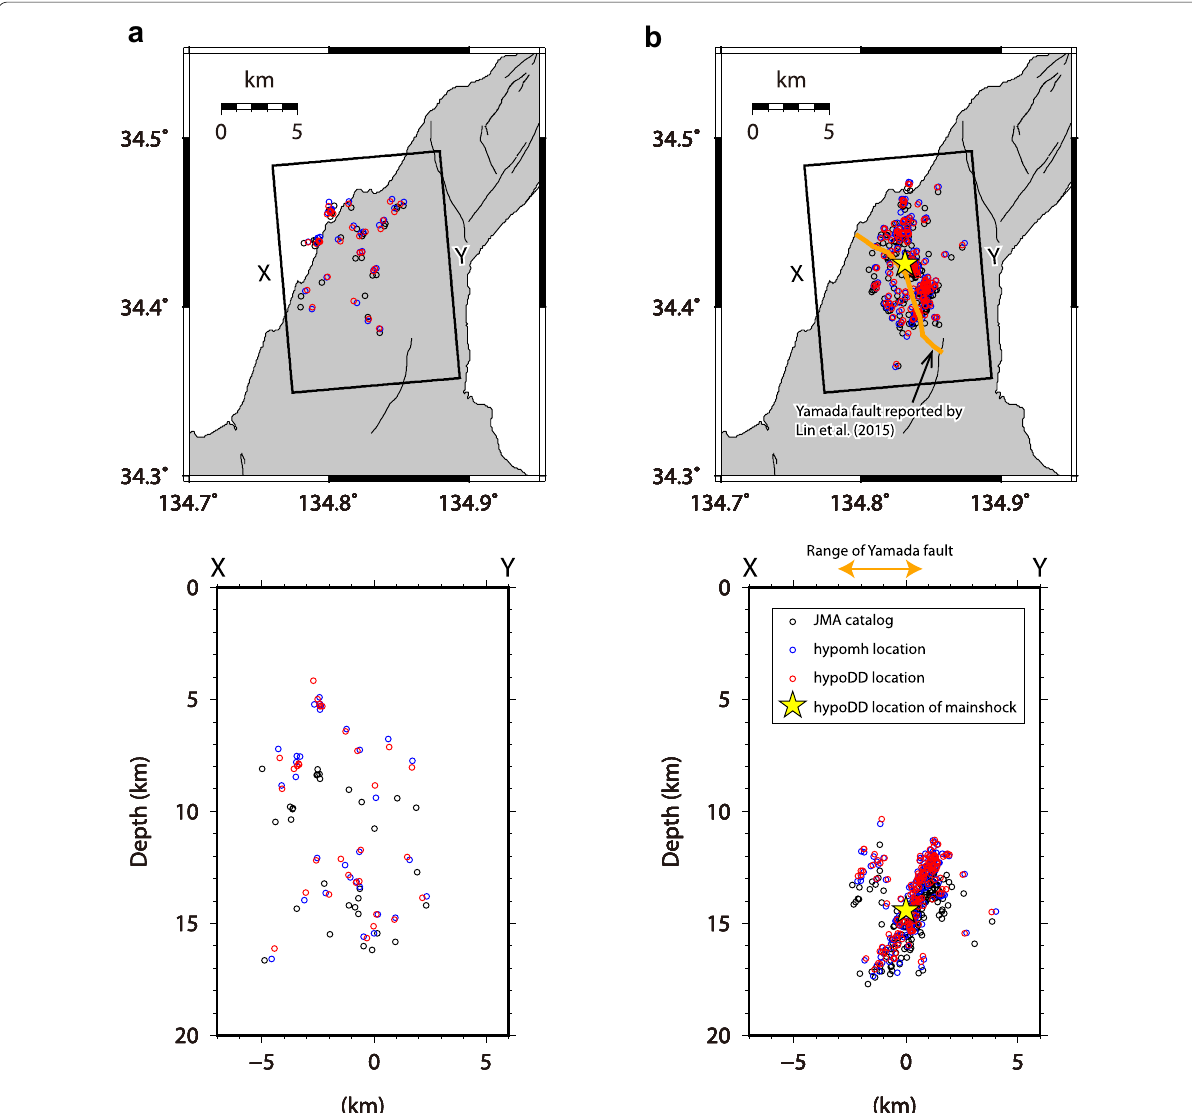
Fig. 4 Hypocenter distributions determined in the present study. Blue, hypomh (Hirata and Matsu’ura 1987); Red and yellow star, hypoDD (Waldhauser and Ellsworth 2000); black, JMA catalogue. a Pre-shock events. b The mainshock and aftershocks. Yamada fault reported by Lin et al. (2015) is shown by an orange line on